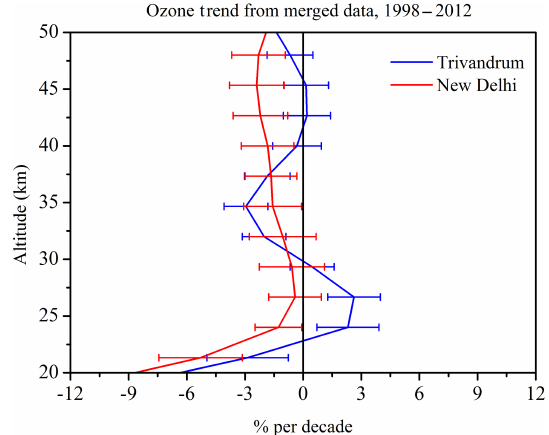
Figure A1. Ozone trend (%decade − 1 ) estimated over Trivandrum (blue) and New Delhi (red) during 1998–2015.